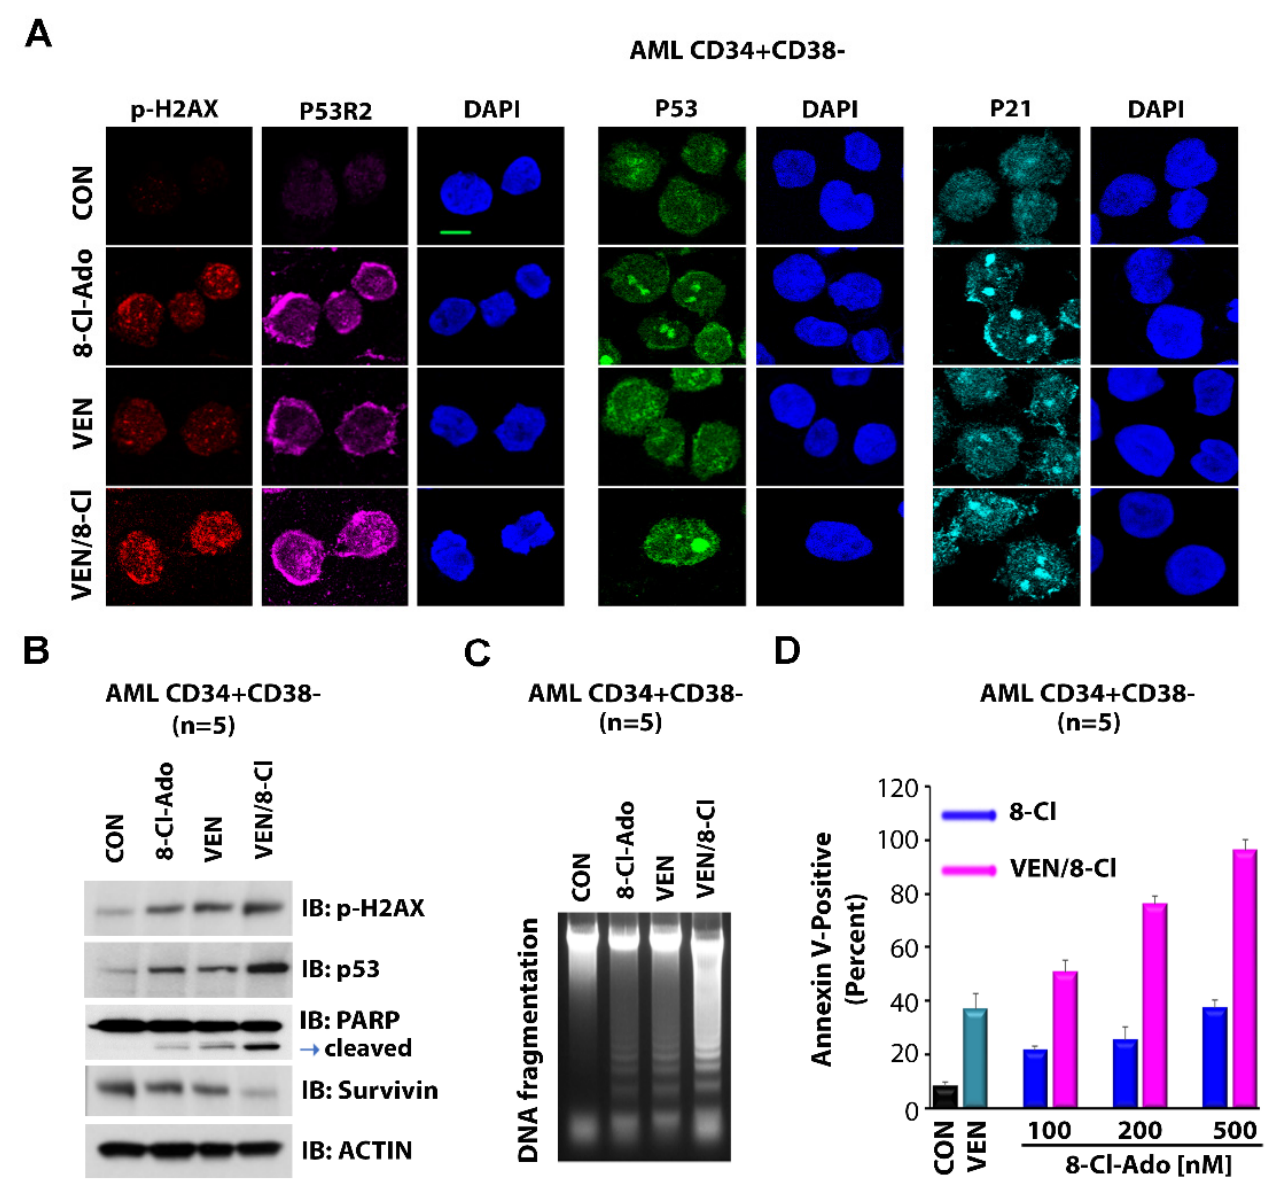
Figure 5. Effects of 8-Cl-Ado plus VEN on p53 signaling and apoptosis. LSC-enriched blasts were treated with 500 nM 8-Cl-Ado, 10 nM VEN or both. ( A , B ) Levels of p-H2AX, p53 and p21 proteins were measured by immunofluorescence and immunoblotting. Original blots see Supplementary File S1. ( C , D ) Levels of apoptosis as determined by DNA fragmentation ( C ) and flow cytometry for Annexin V ( D ). ( D ) n = 2, in triplicate. CON, control; VEN, venetoclax; 8-Cl-Ado, 8-chloro-adeno- sine.